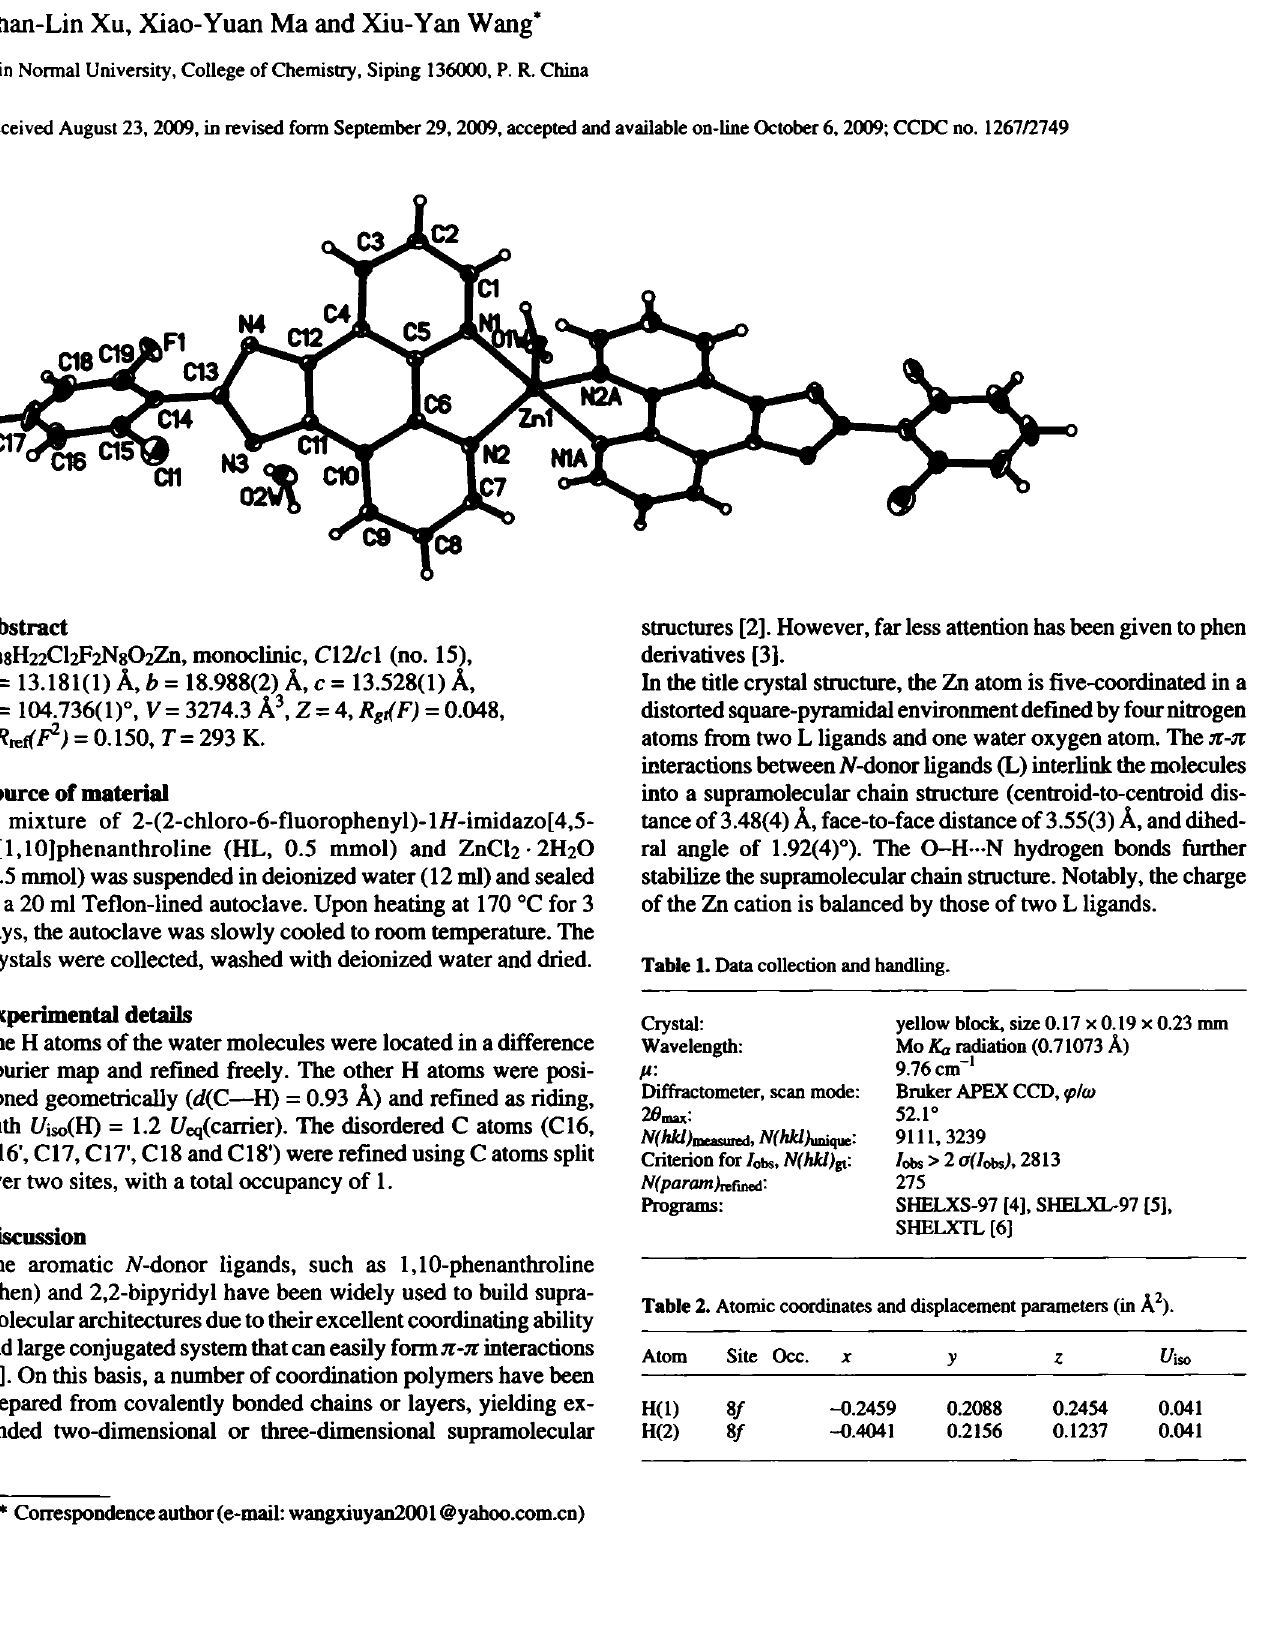
Table 2. Atomic coordinates and displacement parameters (in Ä 2